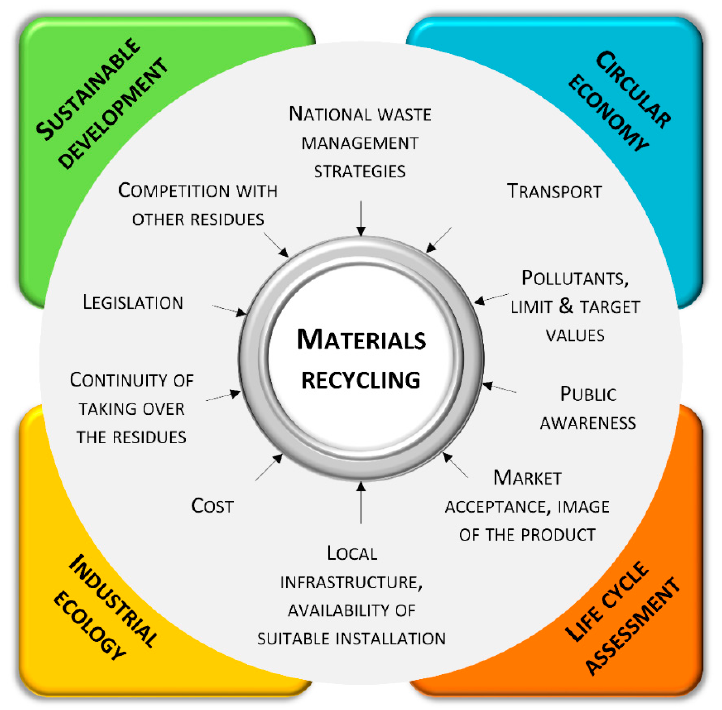
Figure 3. Main factors governing materials recycling.